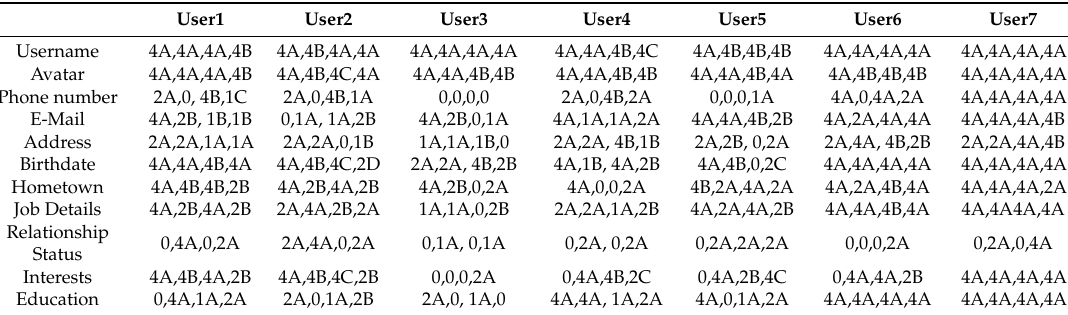
Table 7. Attribute content and accessibility.